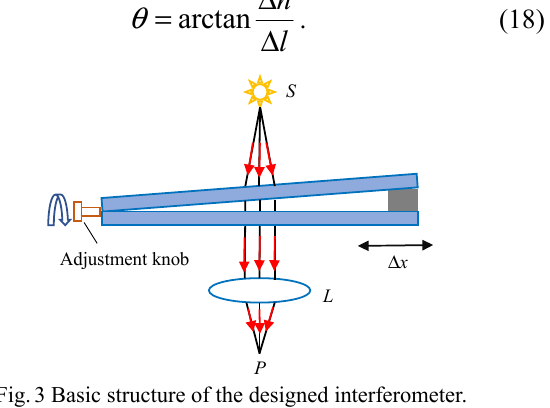
After the optical wedge movement ∆ h ∆ l 𝜽 Before the optical Before the optical wedge movement wedge movement Fig. 4 Schematic diagram of cavity length change after optical wedge